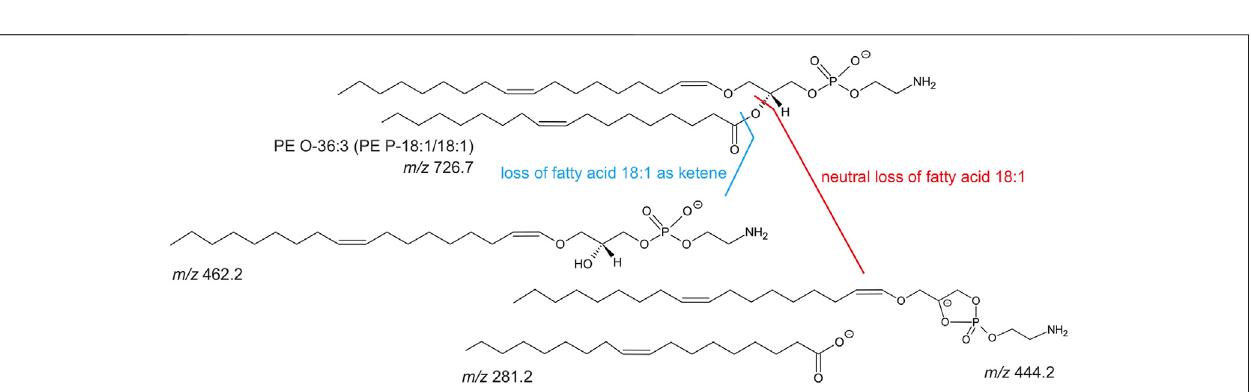
FIGURE5| MolecularstructureofPEO-36:3(m/z726.7as[M-H]-)andknowncollision-induced dissociationfragmentionsafternegativeionization.ThePEO-36: 3 leads to the m/z 281.2 (free fatty acid 18:1), m/z 462.2 (lyso-PE P-18:1) after the loss of fatty acid 18:1 as ketene, or m/z 444.2 after the neutral loss of the fatty acid